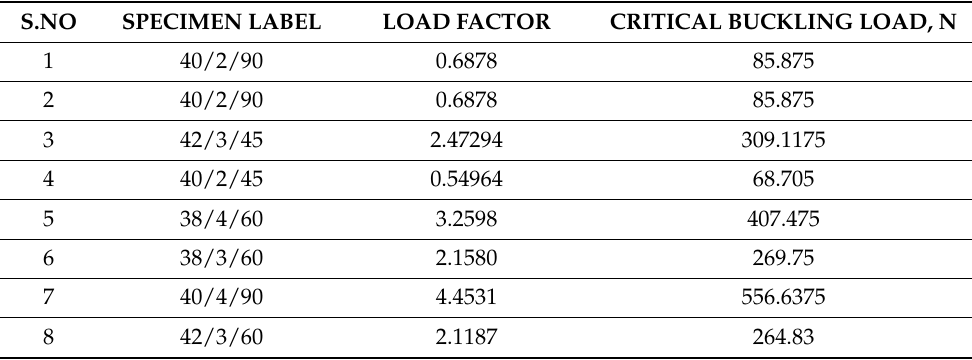
Table 8. Numerical buckling analysis results using